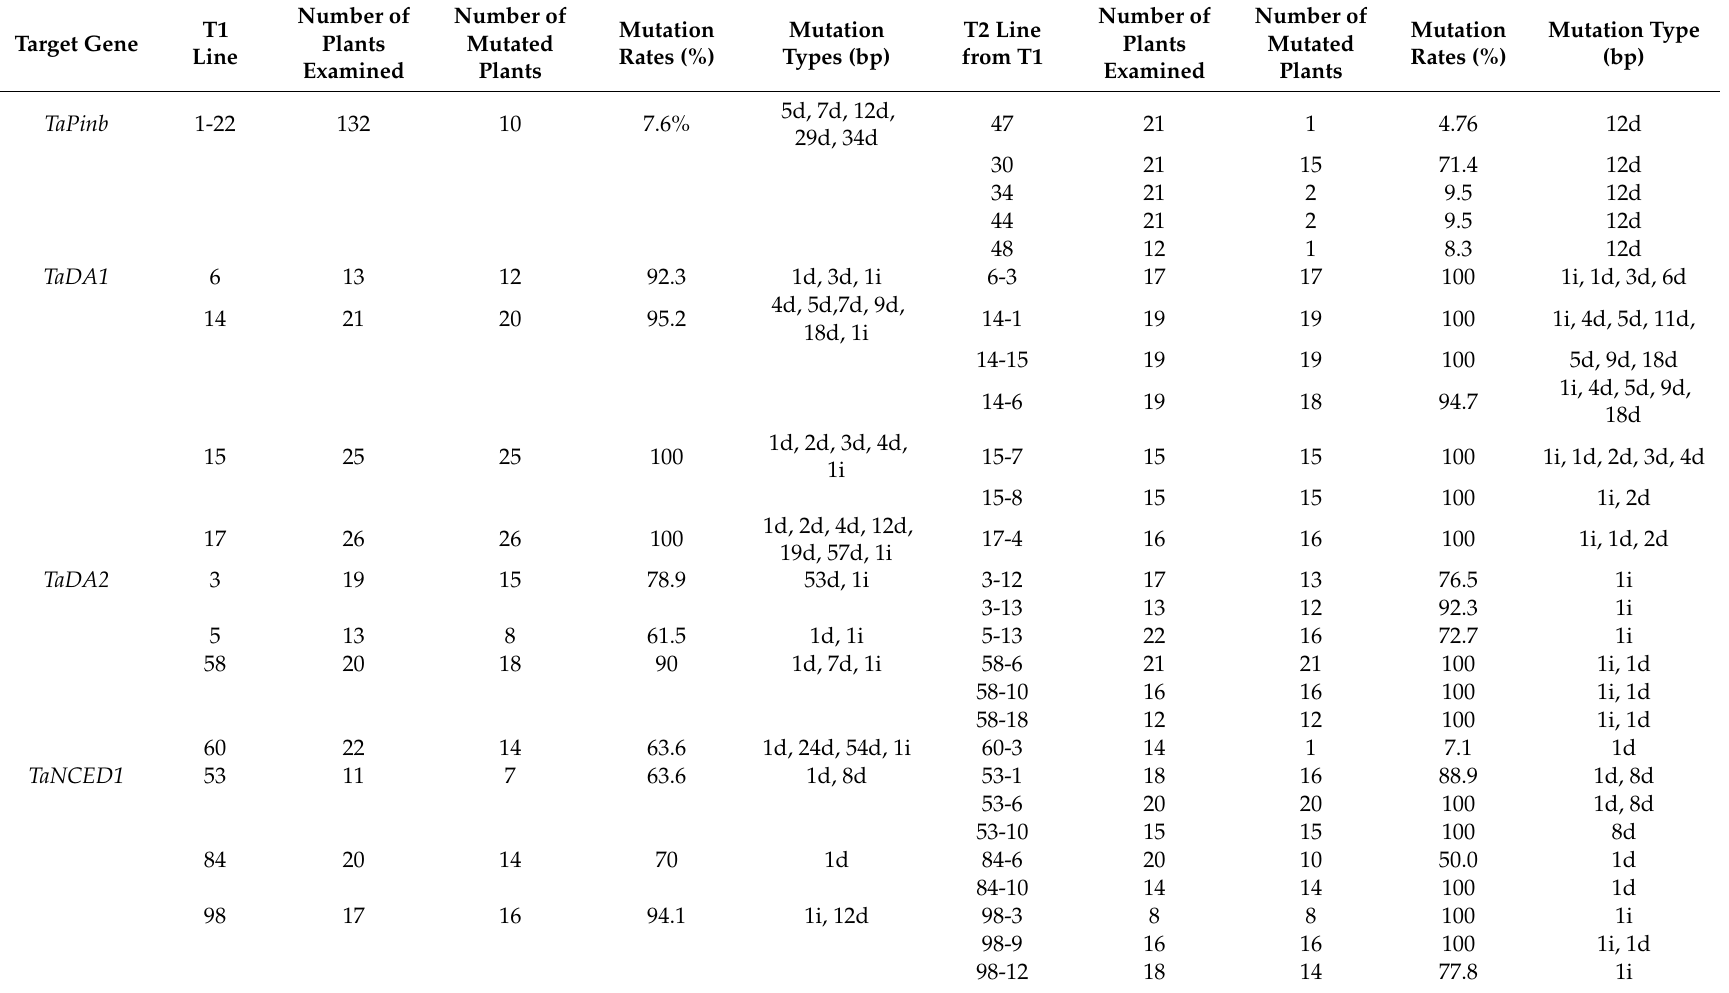
Table 2. Mutation rates and mutation types in the T1 and T2